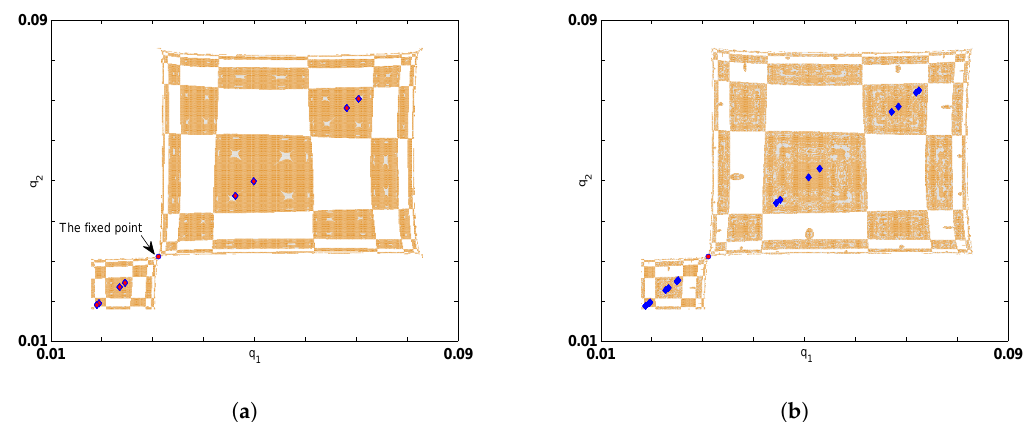
Figure 3. ( a ) Basin of Attraction of period 8-cycle at k = 27.74; ( b ) Basin of Attraction of period 16-cycle at k = 27.965.